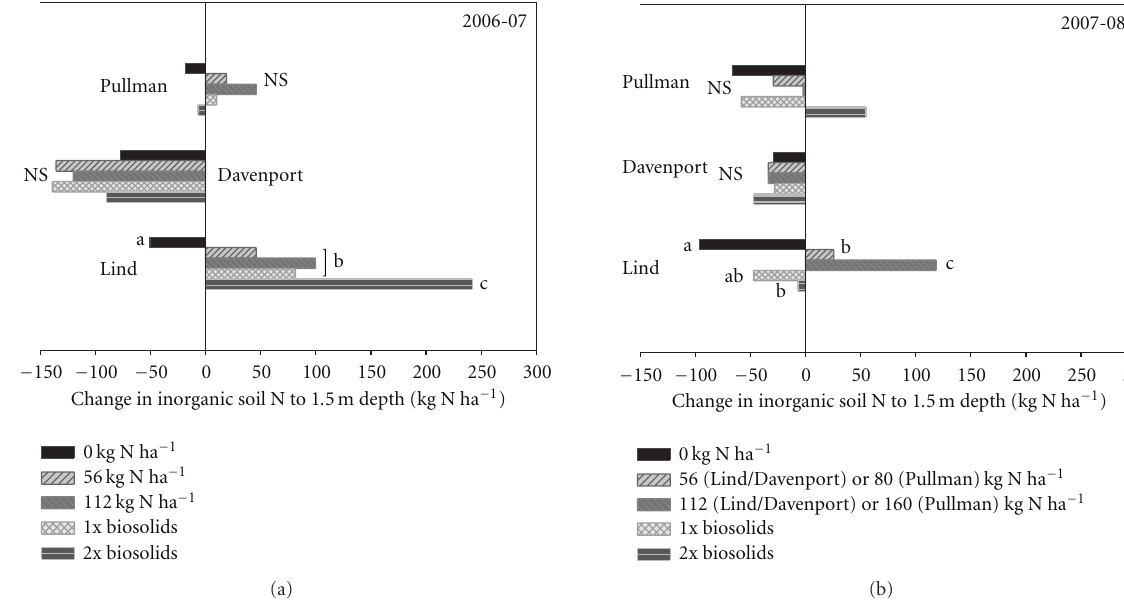
Figure 4: Net changes in total inorganic soil N in a 1.5-m profile between the preplant (Table 1) and postharvest soil sampling of selected fertility treatments in hard red winter wheat at the Lind, Davenport, and Pullman study locations in 2006-07 (a) and 2007-08 (b). Values in the positive (right of vertical line) represent a net gain in soil profile inorganic N compared to the initial (preplant) sampling while values in the negative (left of the vertical line) represent a new depletion of soil profile N. Note the di ff erences in inorganic N application rate between Lind/Davenport and Pullman in